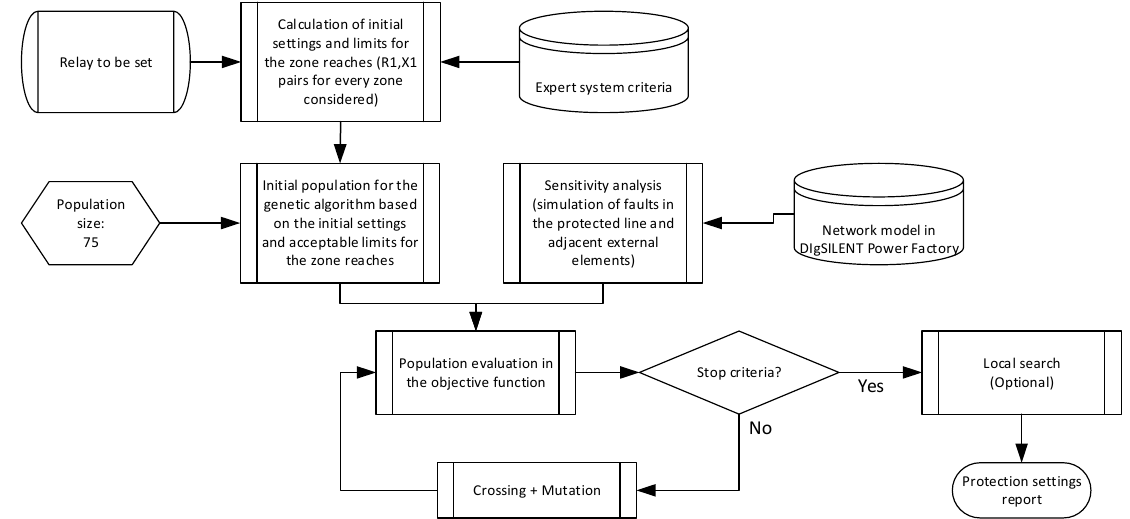
Figure 7. Solution strategy for the optimization problem based on the calculation of distance protection settings in transmission lines.